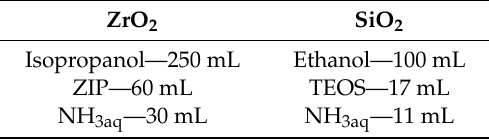
Table 1. Details information about reagents composition used in sol-gel synthesis of M x O y